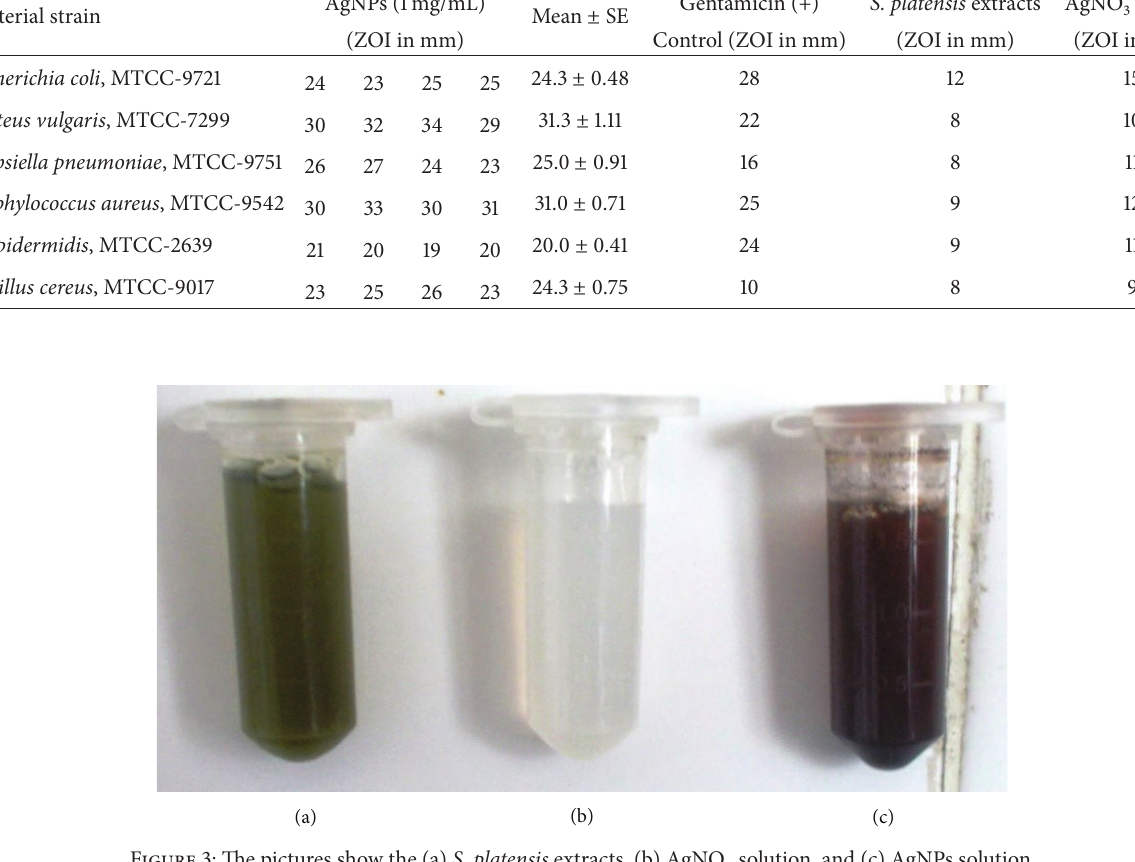
Figure 3: The pictures show the (a) S. platensis extracts, (b) AgNO 3 solution, and (c) AgNPs solution.